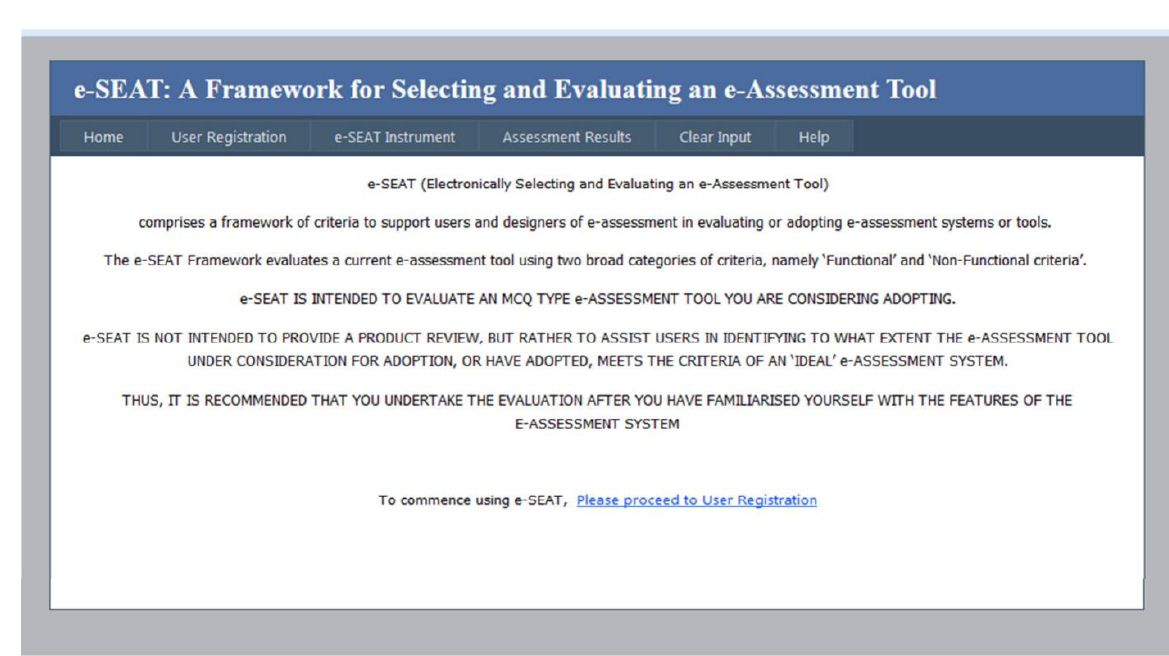
Figure 4. e-SEAT Introductory